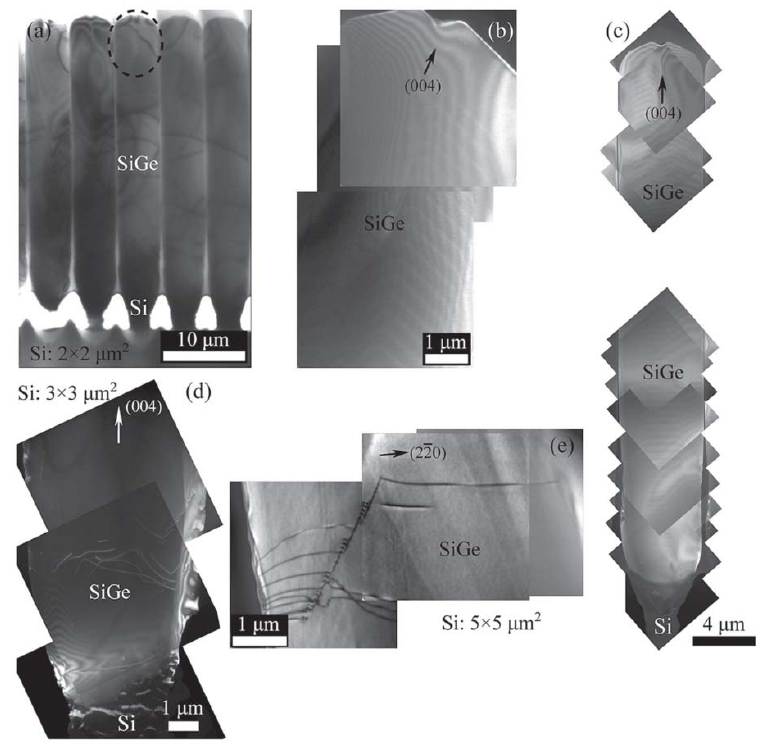
Figure 9. Graded vertical heterostructures. From Ref. [42]: TEM images of Dislocation-free (panels ( a – c )) vs. plastically relaxed ( d , e ) SiGe crystals. Panel b reports the encircled region of panel ( a ) with a higher magnification. Reproduced with permission from [42]. Copyright 2016, Wiley.